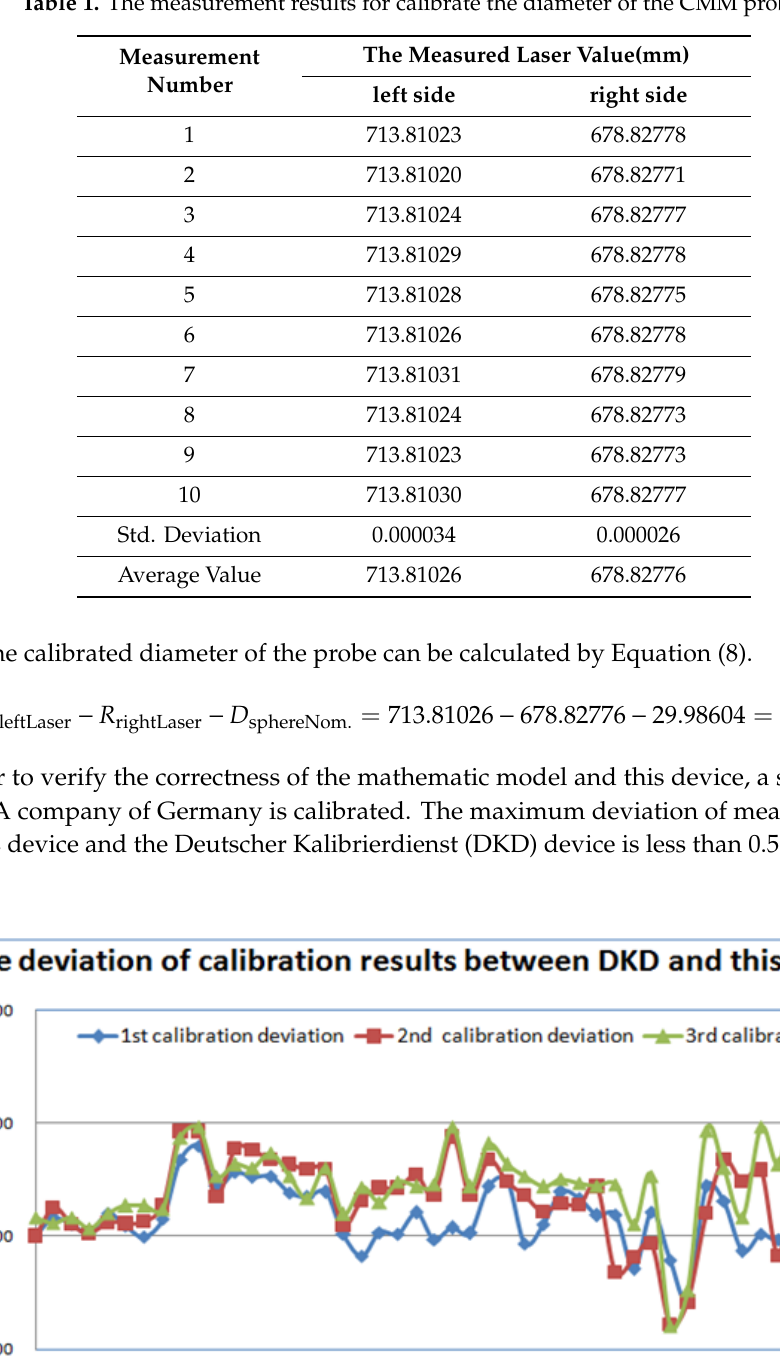
Figure 6. The variation trend of differences between Deutscher Kalibrierdienst (DKD) data and our device with measurement length.